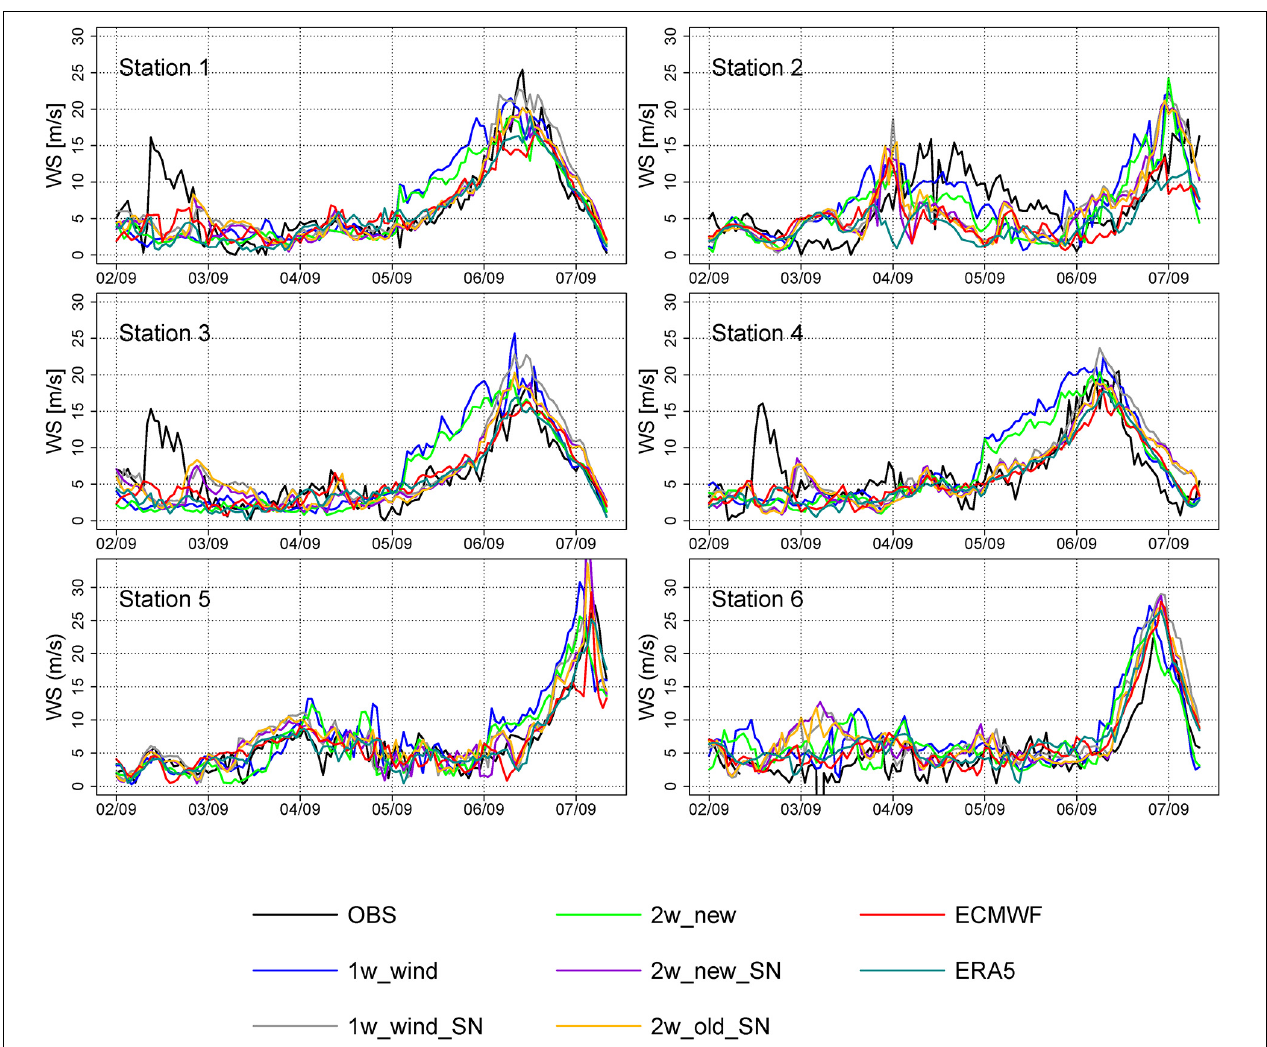
FIGURE 8 | Time series of observed and modeled wind speeds from 2 to 7 September 2019 at different